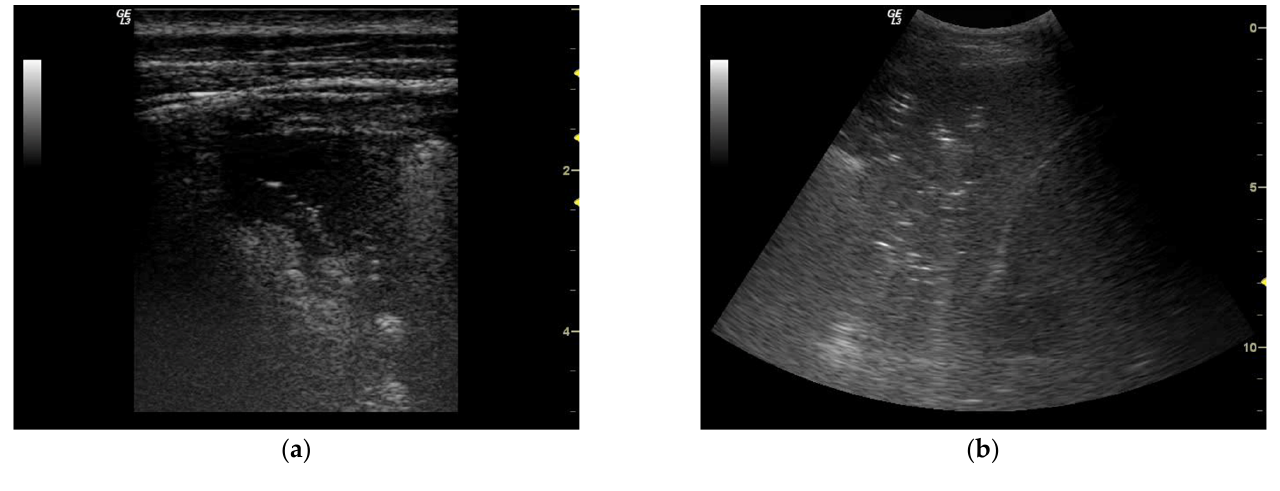
Figure 1. Lung ultrasounds: ( a ) Linear probe. Left superior lobe anterior segment of the lung. Subpleural lobar consolidation with irregular margins; the area of consolidation includes sonographic air bronchogram. ( b ) Curvilinear probe. Right posterior lower lobe posterior basal segment of the lung. Image of tissue echogenicity associated with aerial bronchogram (represented by hyperechoic punctuate images) strongly suggestive for alveolar syndrome.